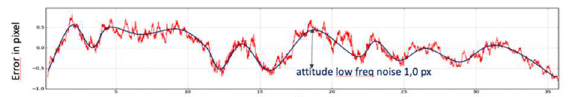
Figure 4. Column misregistration of B05 and B06 on a very long scene (35s) at beginning of life, with navigation data